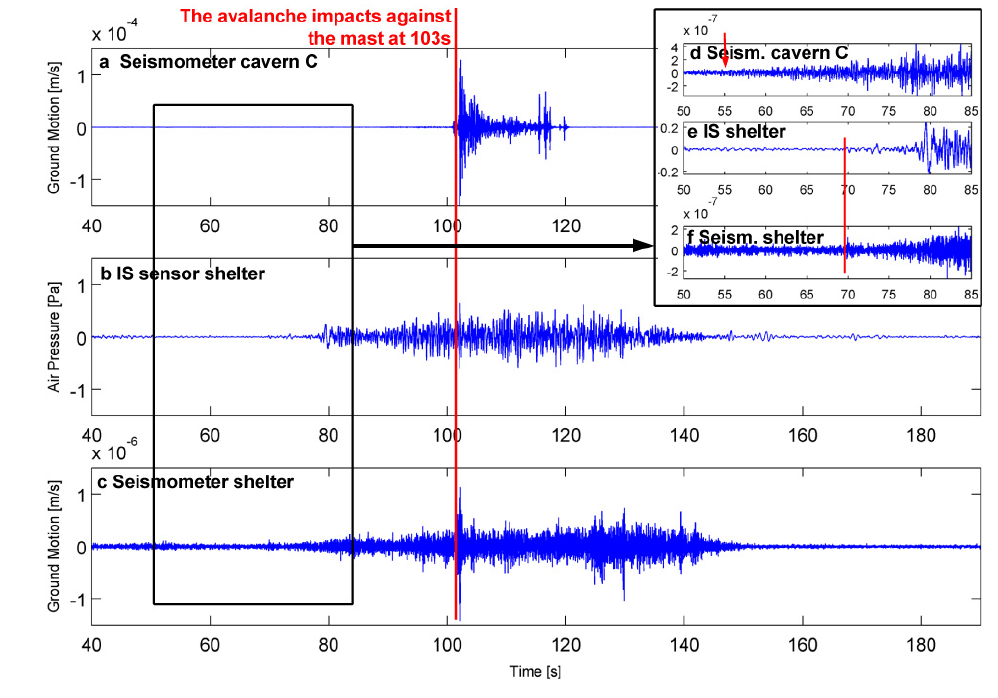
Fig. 12. Seismic Z component and infrasonic data from Avalanche 3. Signals are represented with a common base of time. (a) Seismogram in cavern C; (b) infrasound time series near the shelter; (c) Seismogram near the shelter; (d) magnified Seismogram in cavern C, the arrow indicates the signal arrival (e) magnified infrasound time series; and (g) magnified Seismogram near the shelter, the red line indicates the signal arrival. Note the spindle shape of the signal in (b) and (c) . Magnified time series are shown with a different scale of amplitude and all series are plotted on an arbitrary time scale.